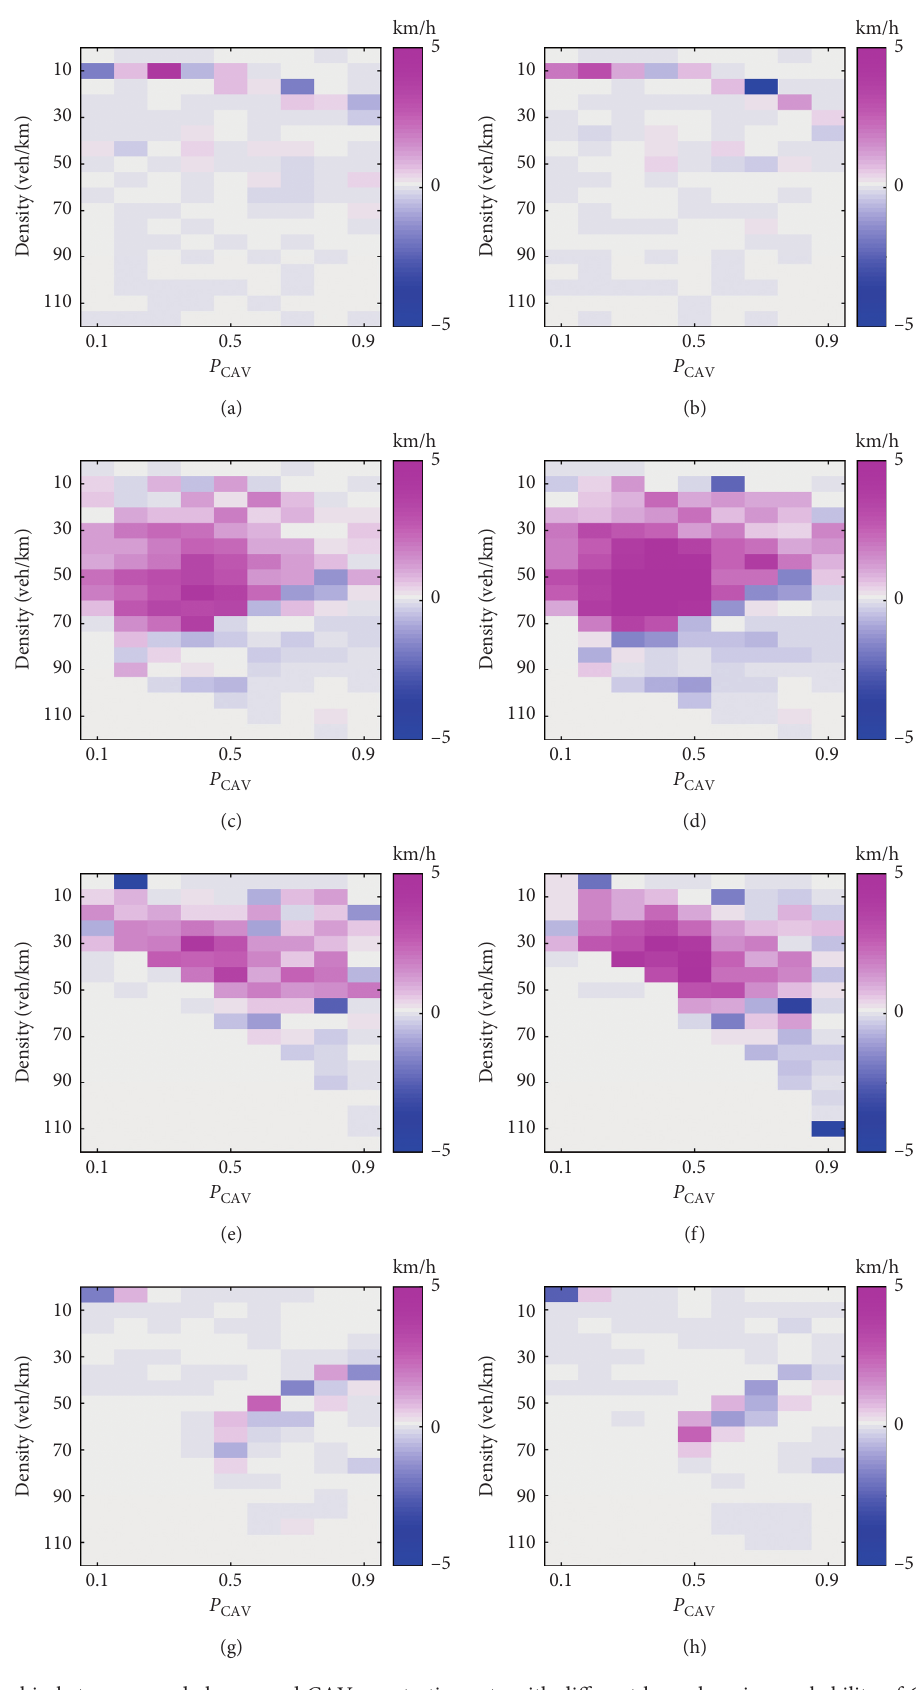
� 0 . 6 lc � 0 . 6 (CCM). (h) lc